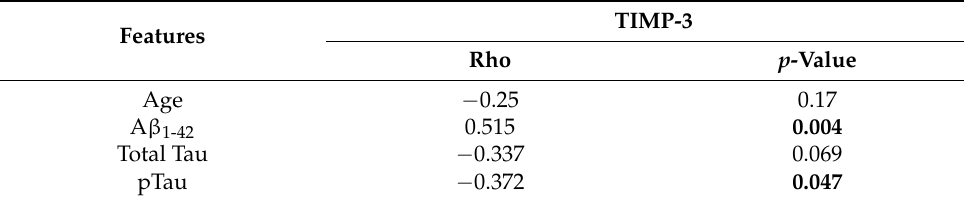
Table 4. Correlation between CSF biomarkers and CSF TIMP-3